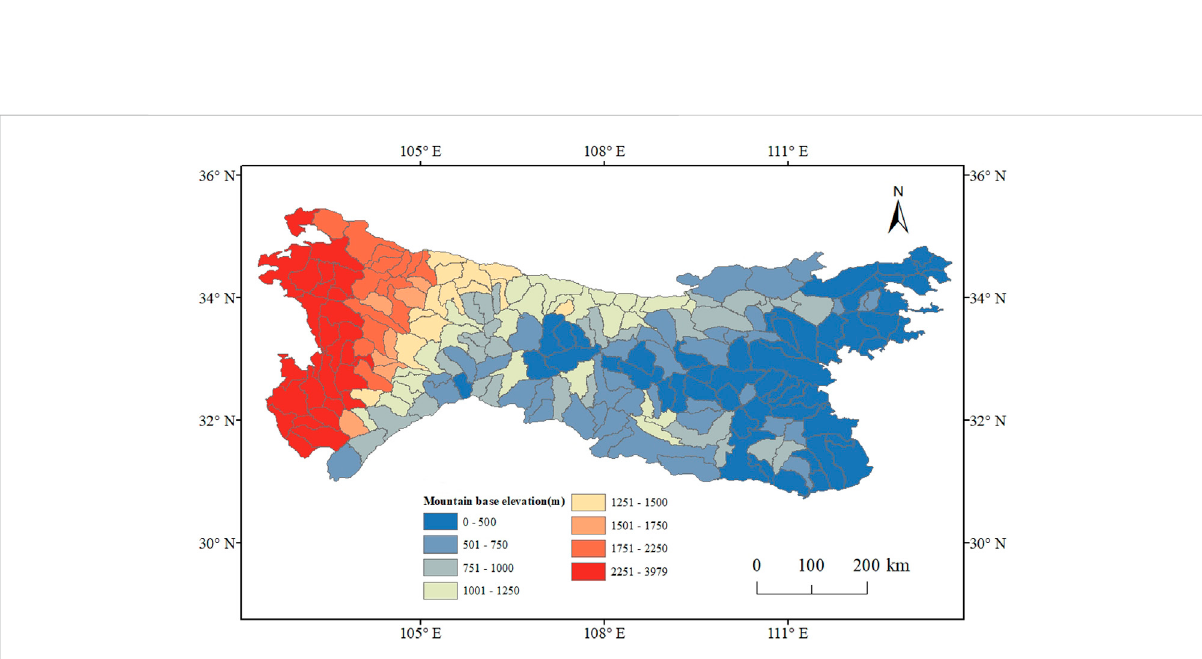
FIGURE 12 Spatial distribution of mountain base elevation in the Qinling-Daba